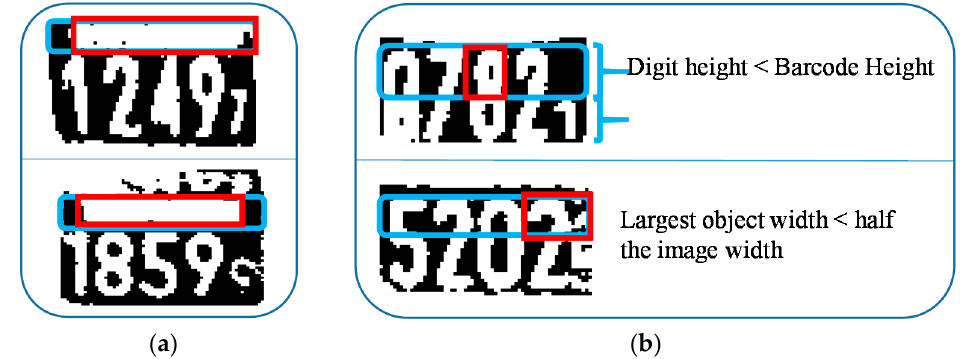
Figure 12. Determination of the digit start point: ( a ) Correctly taken as a start point, ( b ) not taken as a start point.